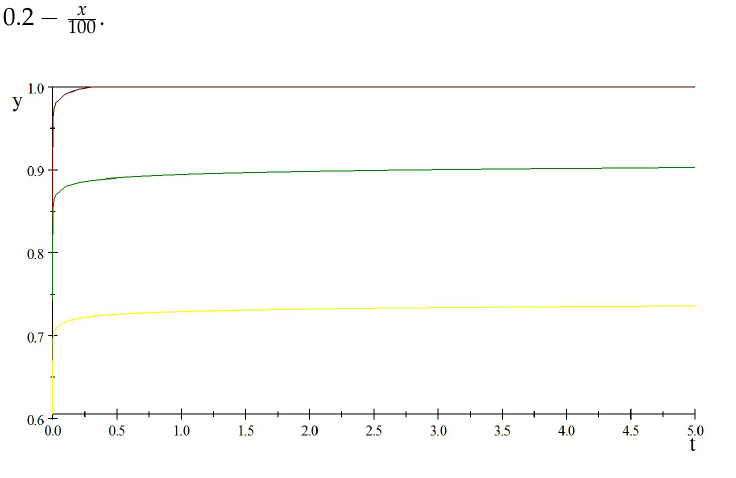
(cid:16) (cid:98) α = 0.2949511, (cid:98) β = 35, q = 0.1, u ( x ) = − 4, b ( x ) = 0.2 −